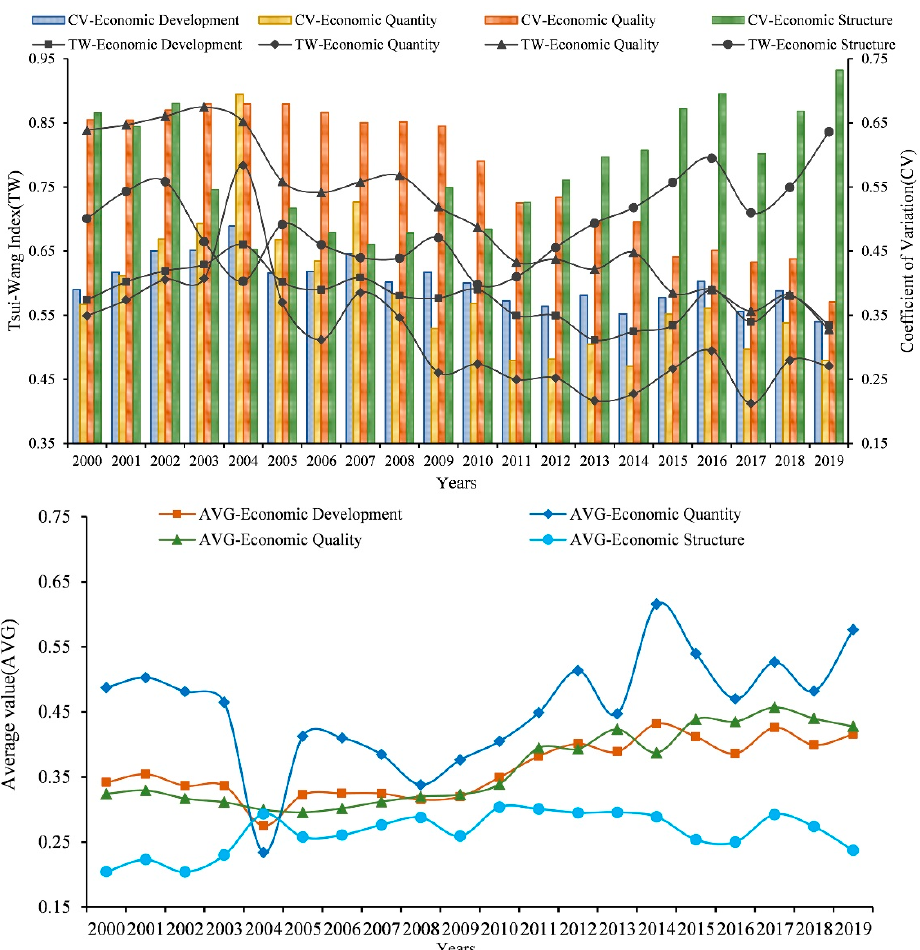
Figure 2. Economic development and evolution of TW index, CV and average value of each dimension.